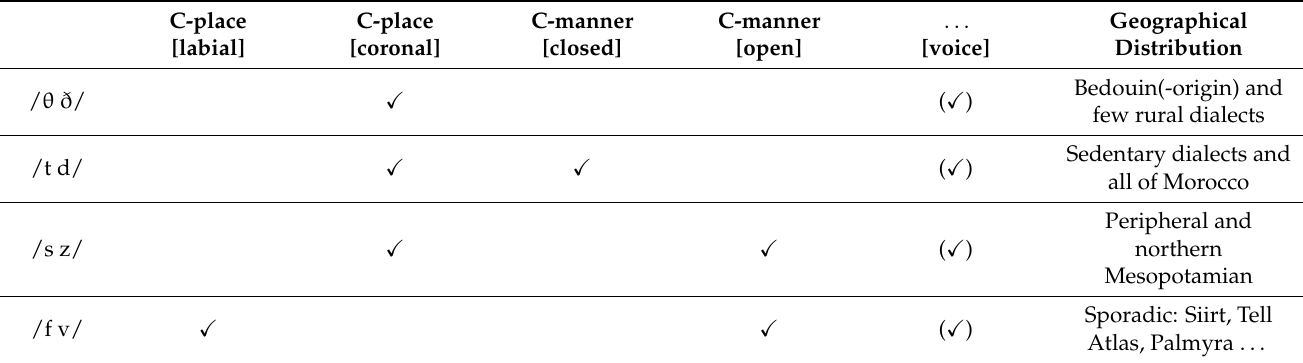
Table 4. Representational typology of * θ –* ð phoneme reflexes 4